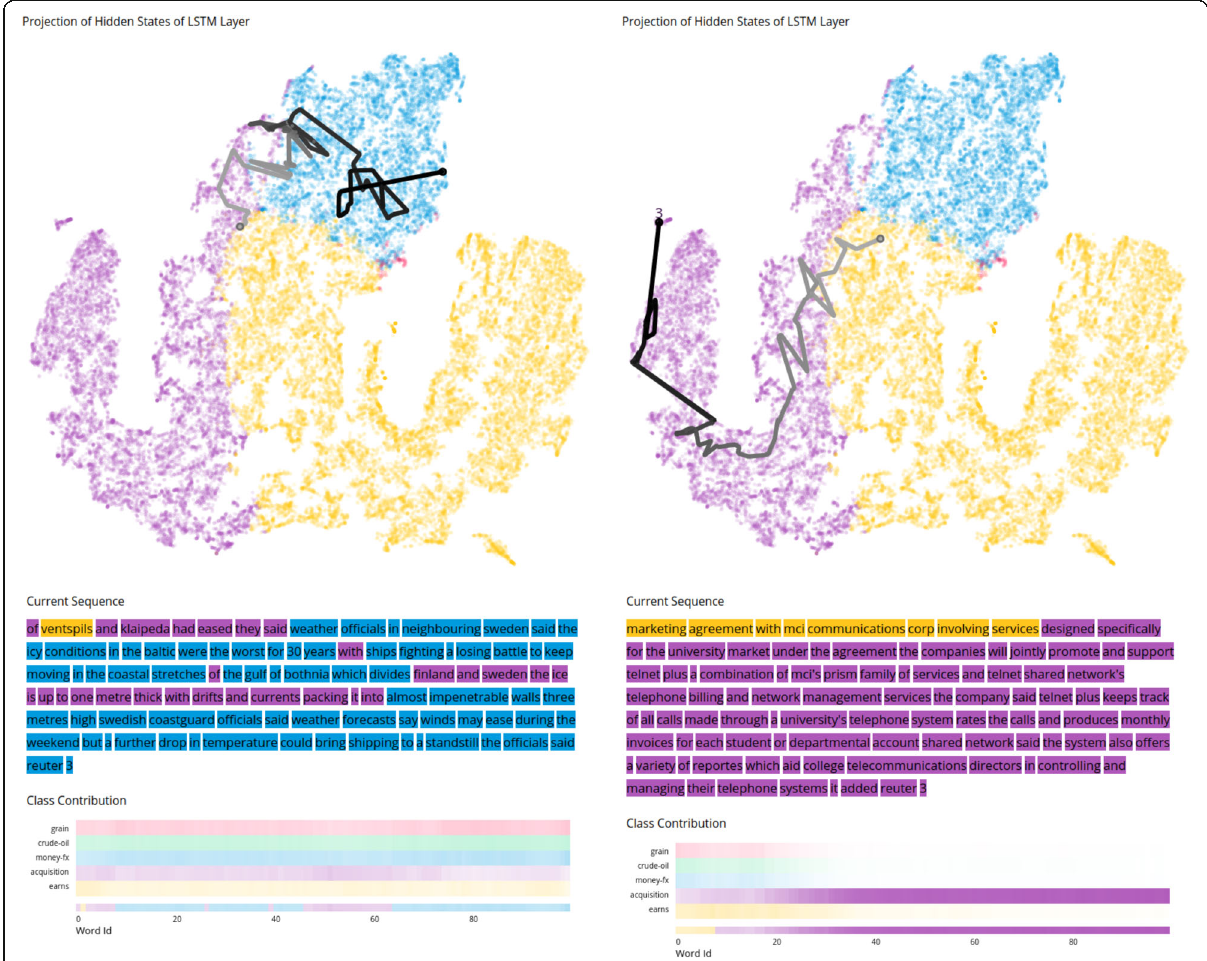
Fig. 8 Examples of incorrectly classified sequences in a model trained for multi-class classification. The heatmap matrix supports the identification of the classes for which the model becomes confused and how the EP evolves throughout the training process, delivering an inaccurate result. In the left visualizations, the prediction is quite uncertain between all five classes. This is visible because the class contributions are similarly transparent for all classes. In the right visualizations, the model is rather certain in the classification of acquisition (violet), despite the correct class being earns (yellow). Underlying data source: Reuters